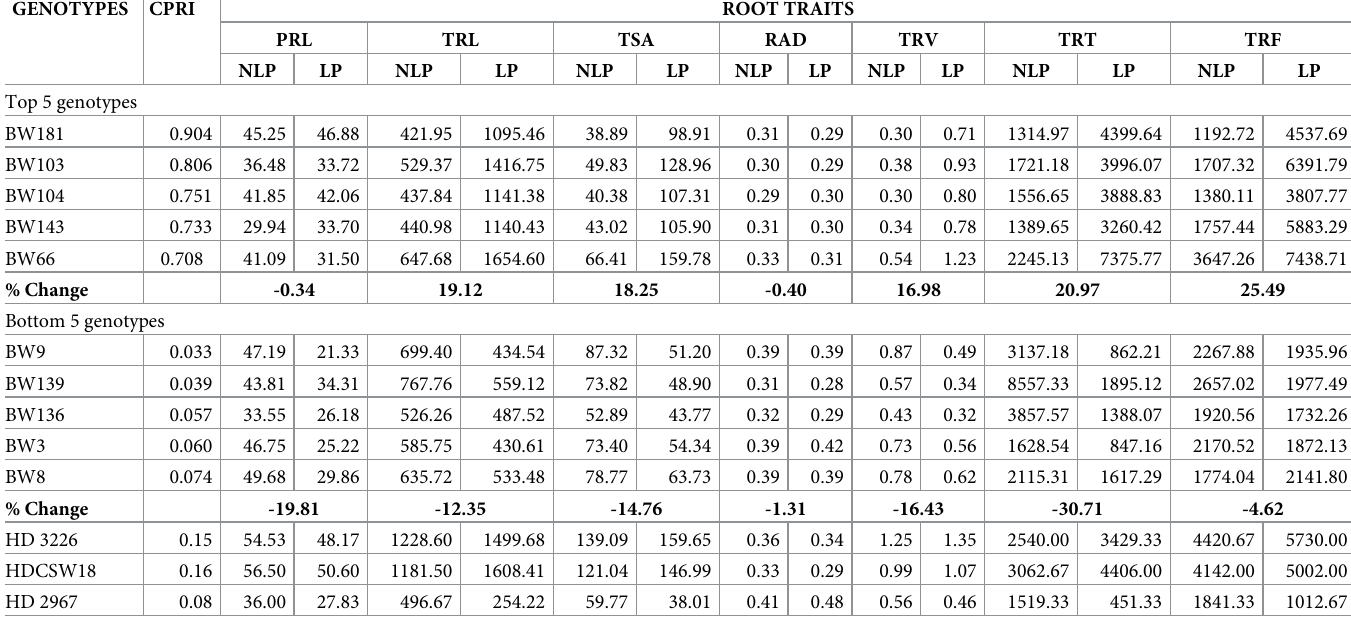
Table 5. Comprehensive phosphorus response index values and top ten contrasting wheat genotypes for seven root system architectural traits under non-limiting and limiting phosphorus conditions. GENOTYPES